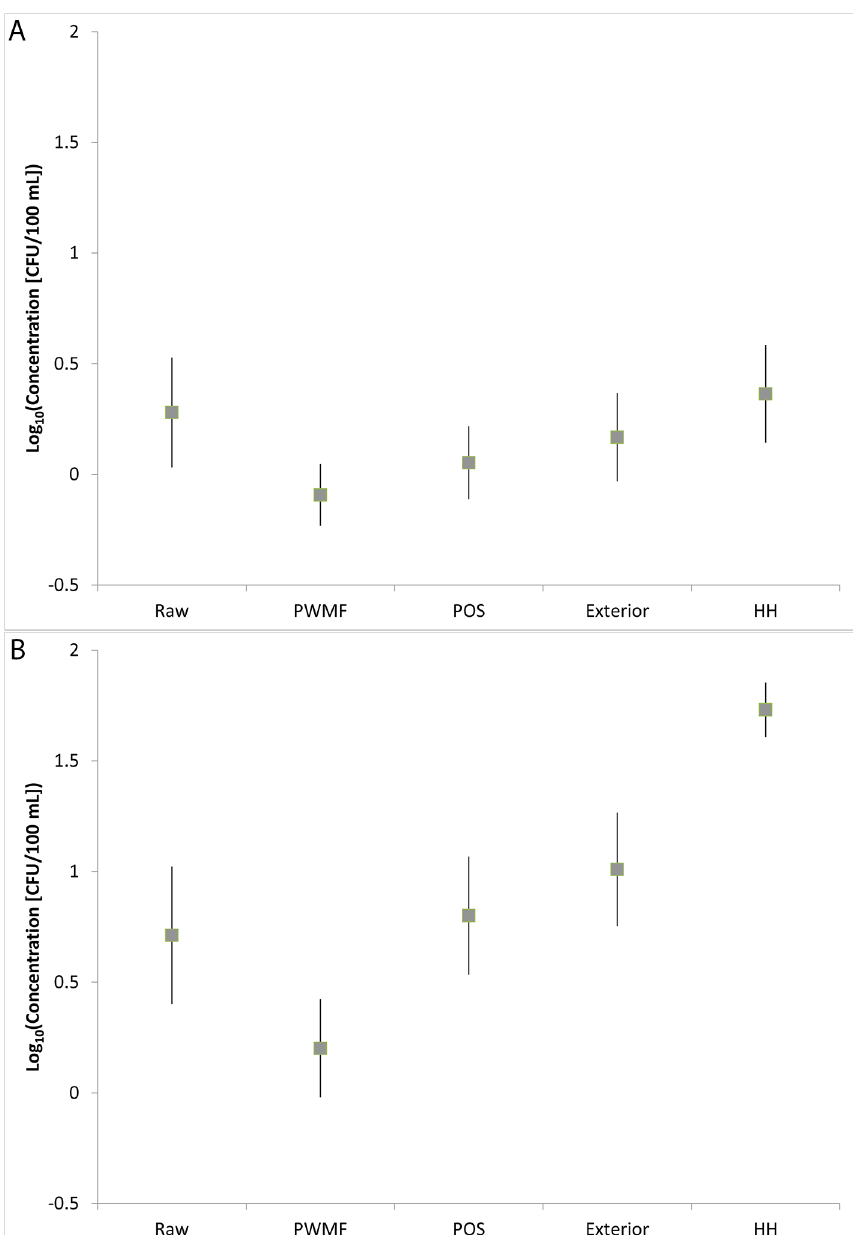
Fig 2. Log bacterial concentrations in samples. Log of A) E . coli and B) Total coliform concentrations (CFU/100 mL) measured in raw water and finished packaged sachet water (PSW) samples at the packaged water manufacturing facility ( “ Raw ” and “ PWMF ” , respectively) and in PSW samples as well as on the exterior of PSW samples at the point of sale ( “ POS ” and “ Exterior ” , respectively) and in household water for consumption ( “ HWC ” ). Boxes represent average log concentrations, whiskers represent 95% confidence intervals for log concentrations.